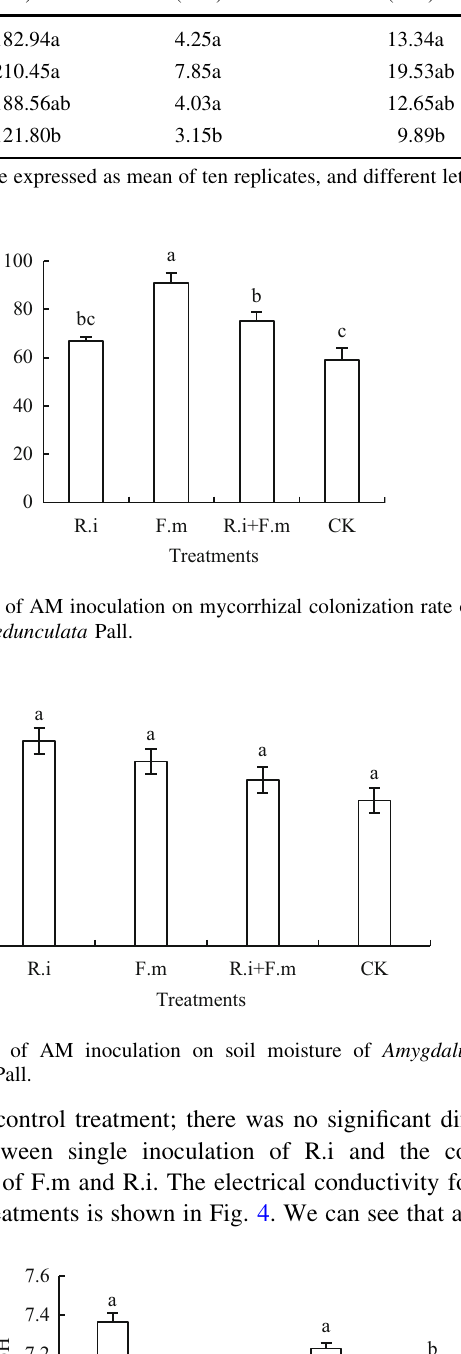
Table 1 Effect of AM inoculation on root morphology of Amygdalus pedunculata Pall. Treatment Total root length (cm)